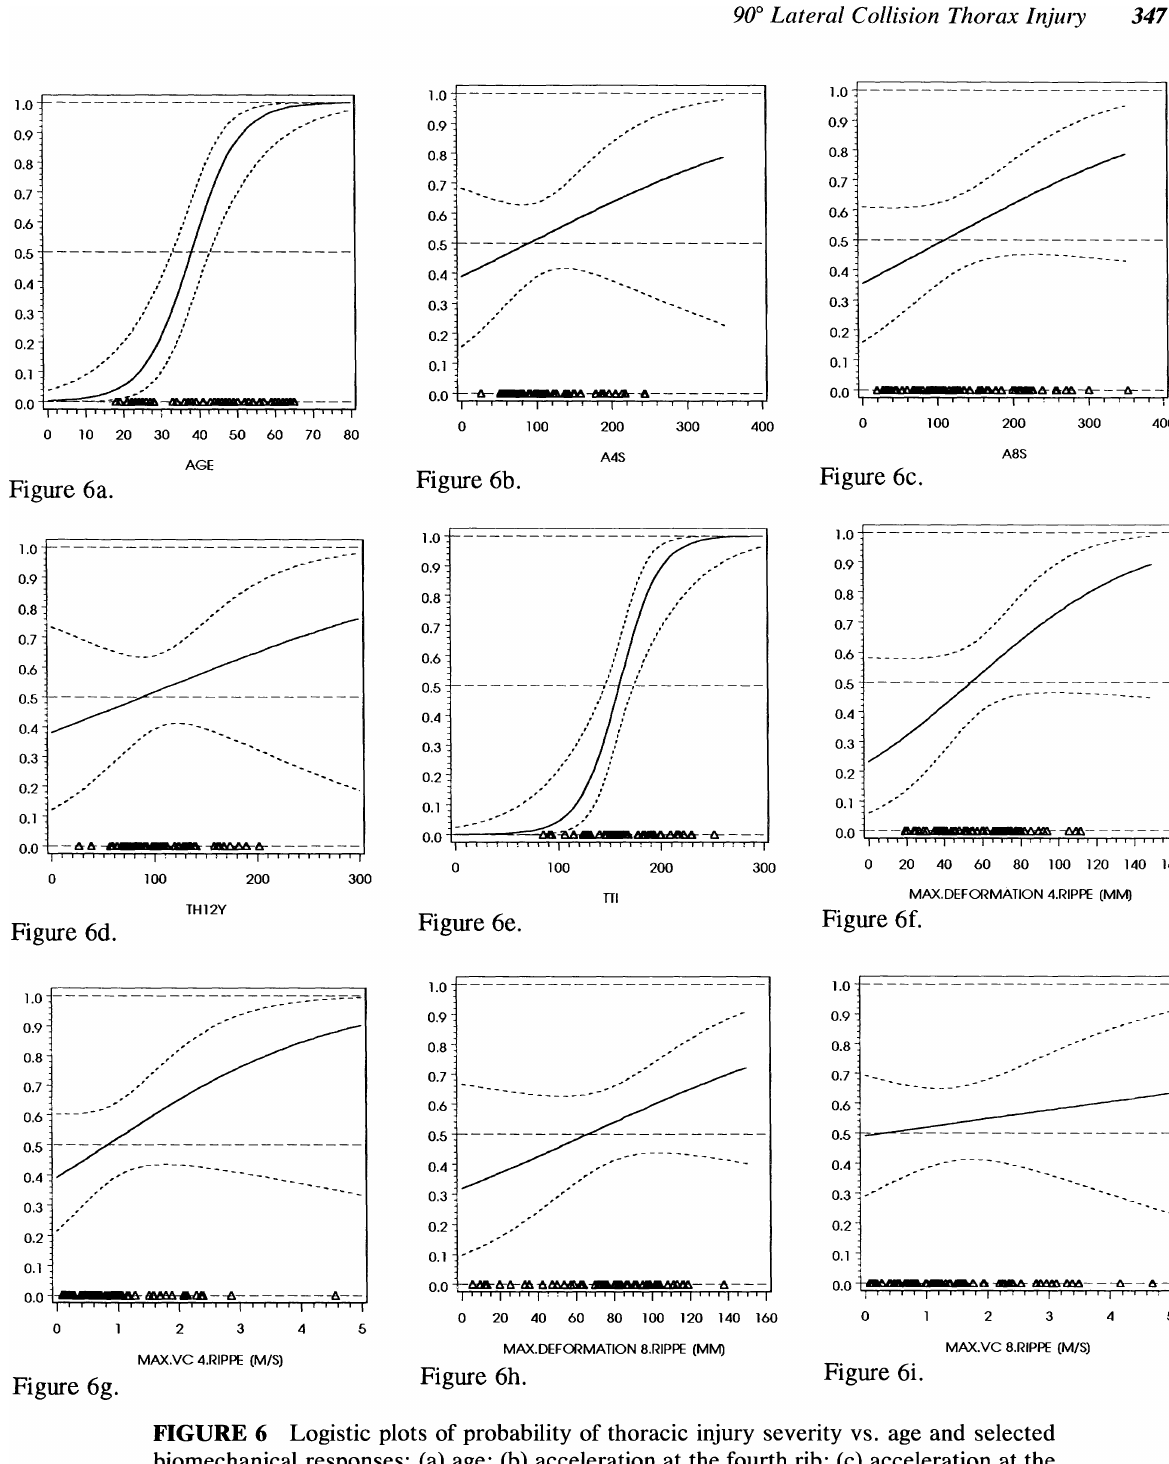
FIGURE 6 Logistic plots of probability of thoracic injury severity vs. age and selected biomechanicaI responses: (a) age; (b) acceleration at the fourth rib; (c) acceleration at the eighth rib; (d) acceleration at the 12th thoracic vertebrae; (e) ITI; (0 deformation at the level of the fourth rib; (g) VC at the level ofthe fourth rib; (h) deformation at the level of the eighth rib; and (i) VC at the level of the eighth rib. (The triangles at the bottom mark the range of the corresponding